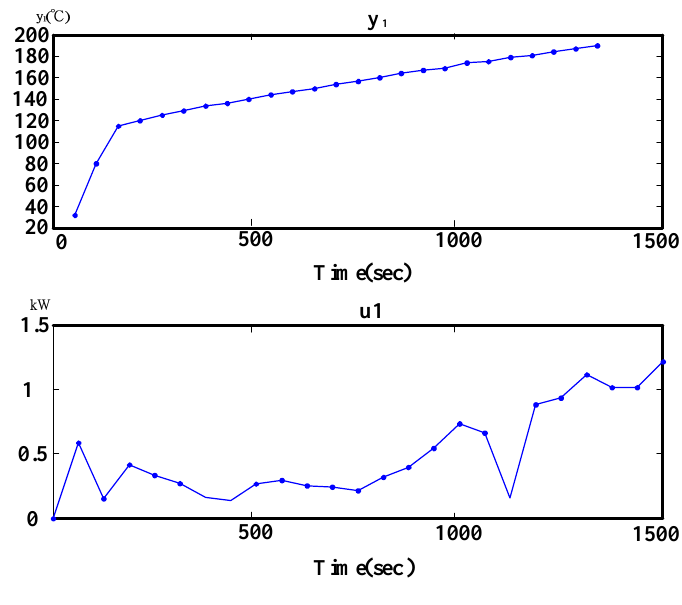
Figure 8. Dynamic response of actual system input and